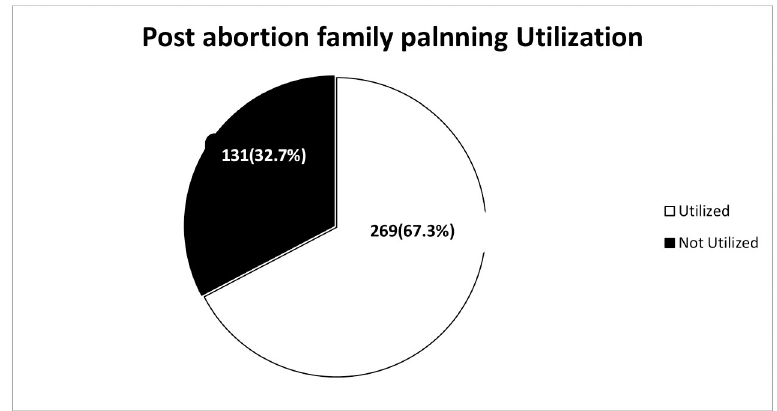
Fig 1. Level of post-abortion family planning utilization in health facilities among abortion clients in Wolaita Sodo town, 2019.